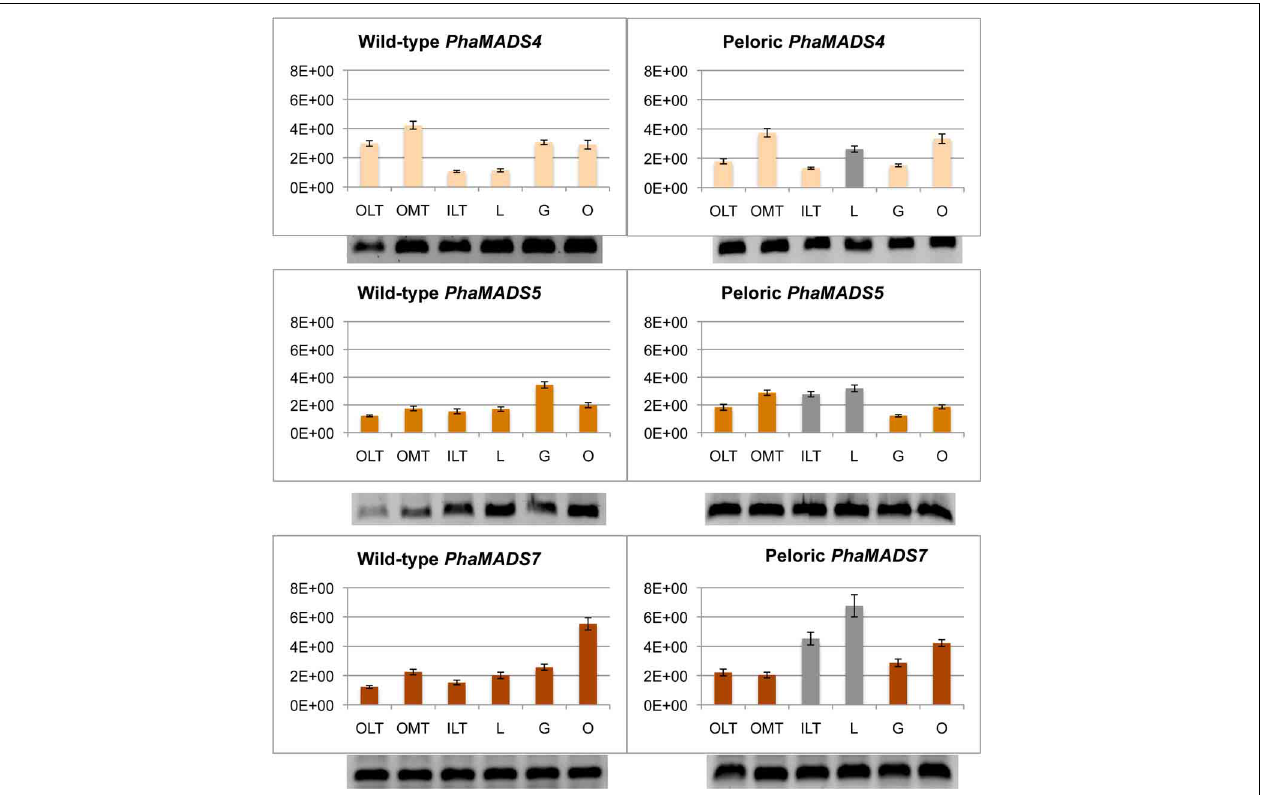
FIGURE 6 | Normalized expression of orchid SEPALLATA -like genes. Expression of PhaMADS4 and PhaMADS5 and PhaMADS7 in six flower organs of wild-type and peloric of Phalaenopsis hybrid “Athens.” Replicates, normalization, graphics and abbreviations are as in Figure 5